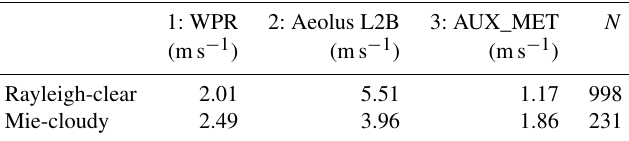
Table B2. Error standard deviation of three different systems based on the error estimate threshold values of 7ms − 1 for Rayleigh-clear and 5ms − 1 for Mie-cloudy